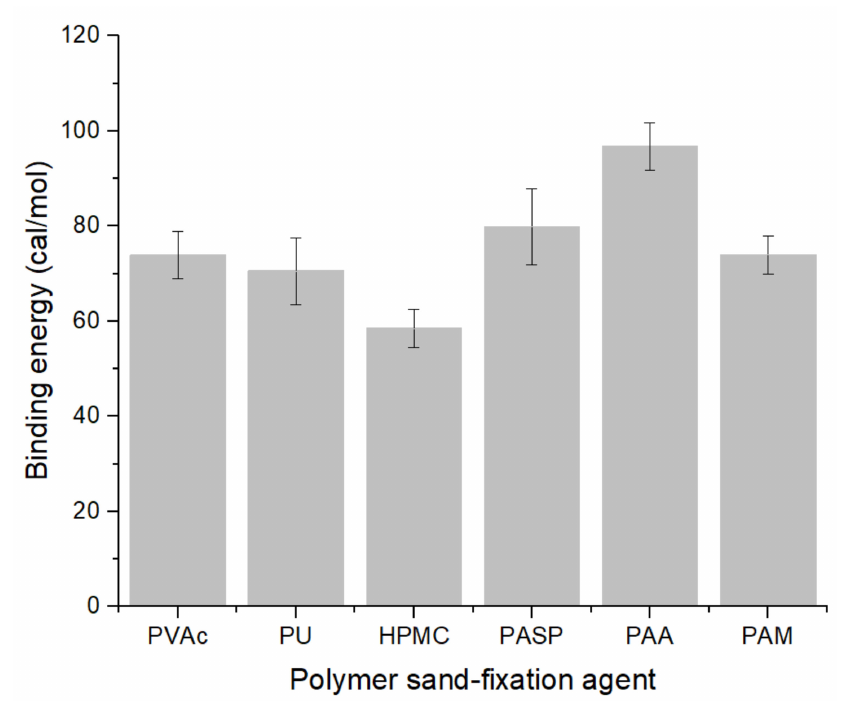
Figure 3. Binding energy of polymer sand-fixing